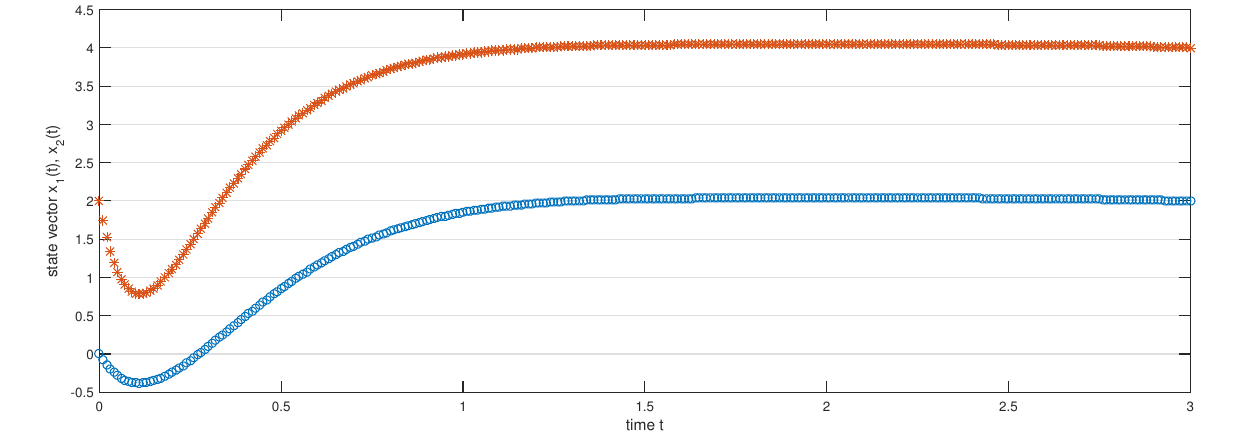
Figure 1. State with control function steers initial state x ( 0 ) = ( 0,2 ) T to final state x ( 2 ) = ( 2,4 ) T .